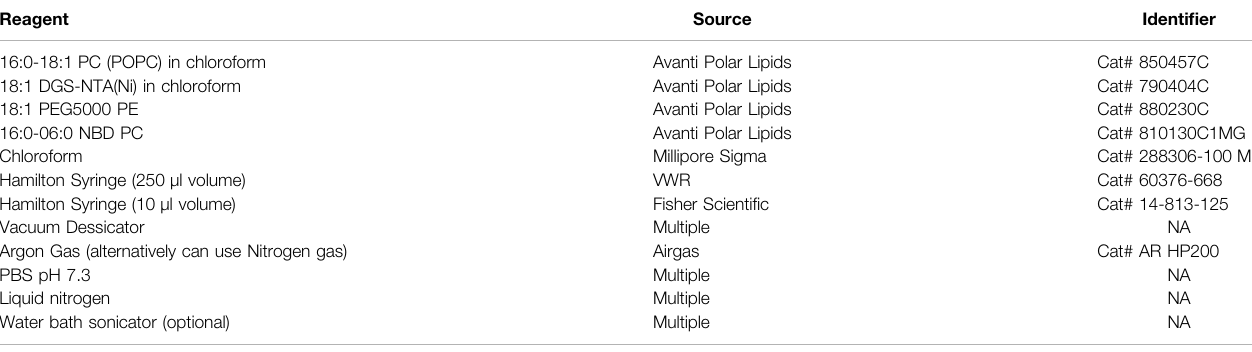
TABLE3| Reagentsforpreparingsmallunilamellarvesicles(SUVs).Manychemicalsandsupplieshavenumerousoptionsavailablefrommultiplecompanies.Wehavelisted some of the speci fi c items we have used to perform these assays. Reagent 16:0-18:1 PC (POPC) in chloroform